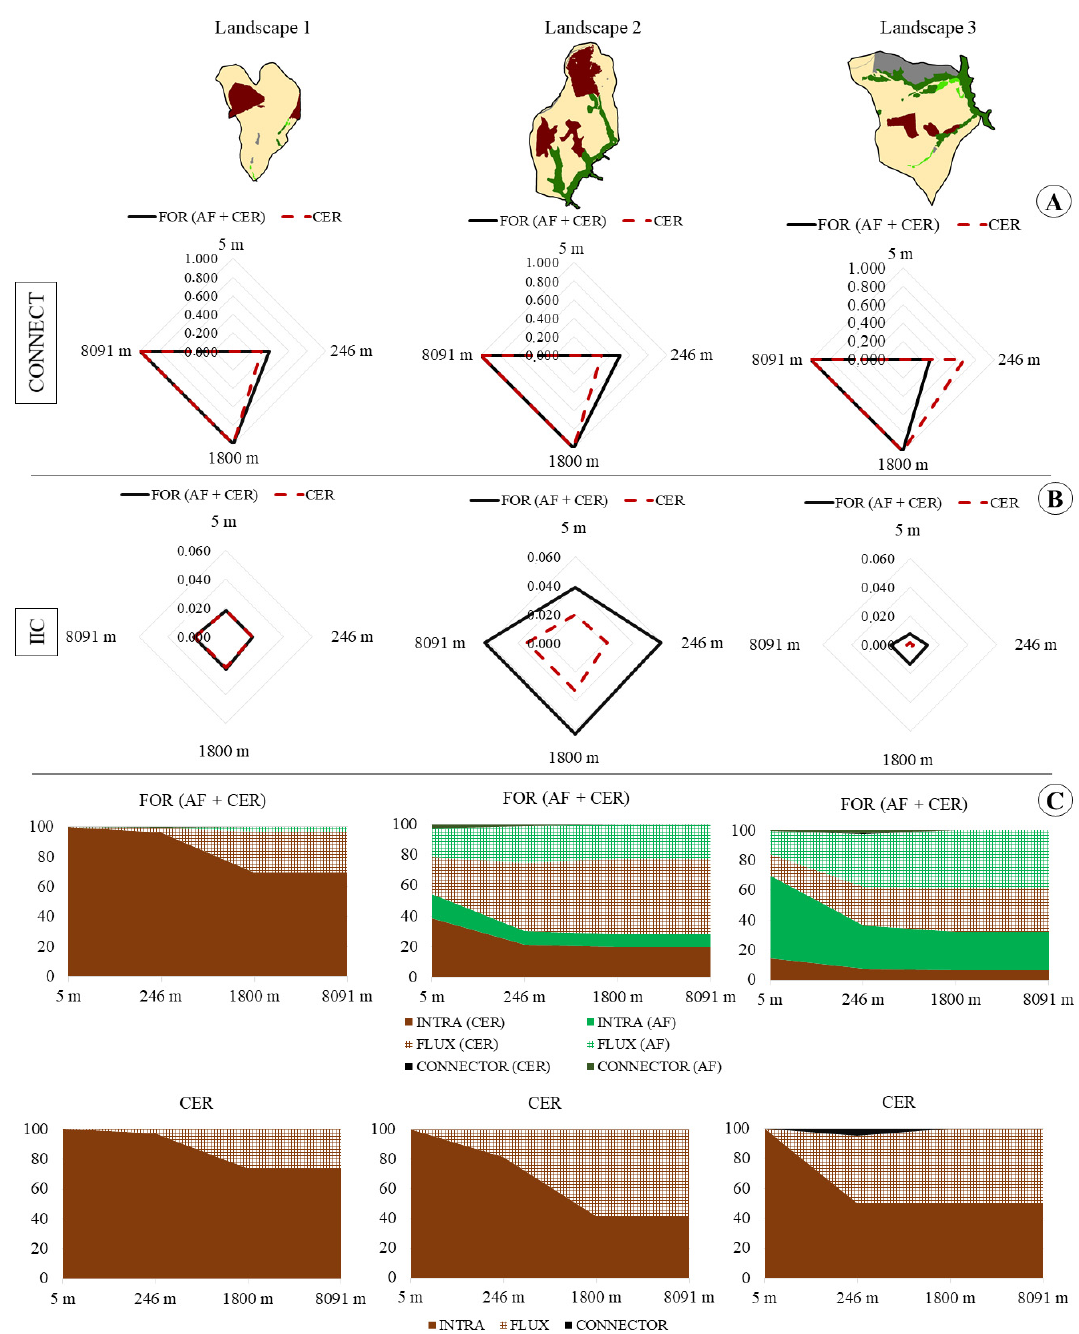
Figure 4. Measures of the functional connectivity of the three landscapes in the four distance profiles of plant dispersal (short—5 m, medium—246 m, medium–long—1800 m, and long—8091 m) for all forest cover (FOR) and for the cerradão (CER) only: ( A ) Connectivity index (CONNECT); ( B ) Integral connectivity index (IIC); and ( C ) contribution of intra , flux, and connector fractions to the general IIC. Appendix B Table A1 provides these data.